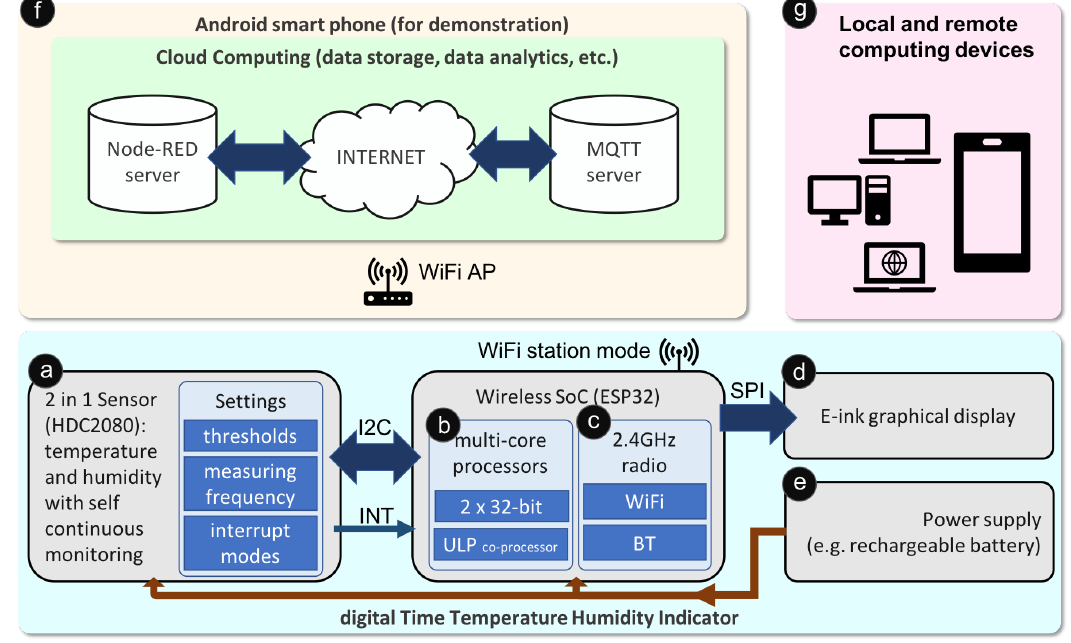
Figure 2. Block diagram of a dTTHI for medicine reuse based on the IoPT